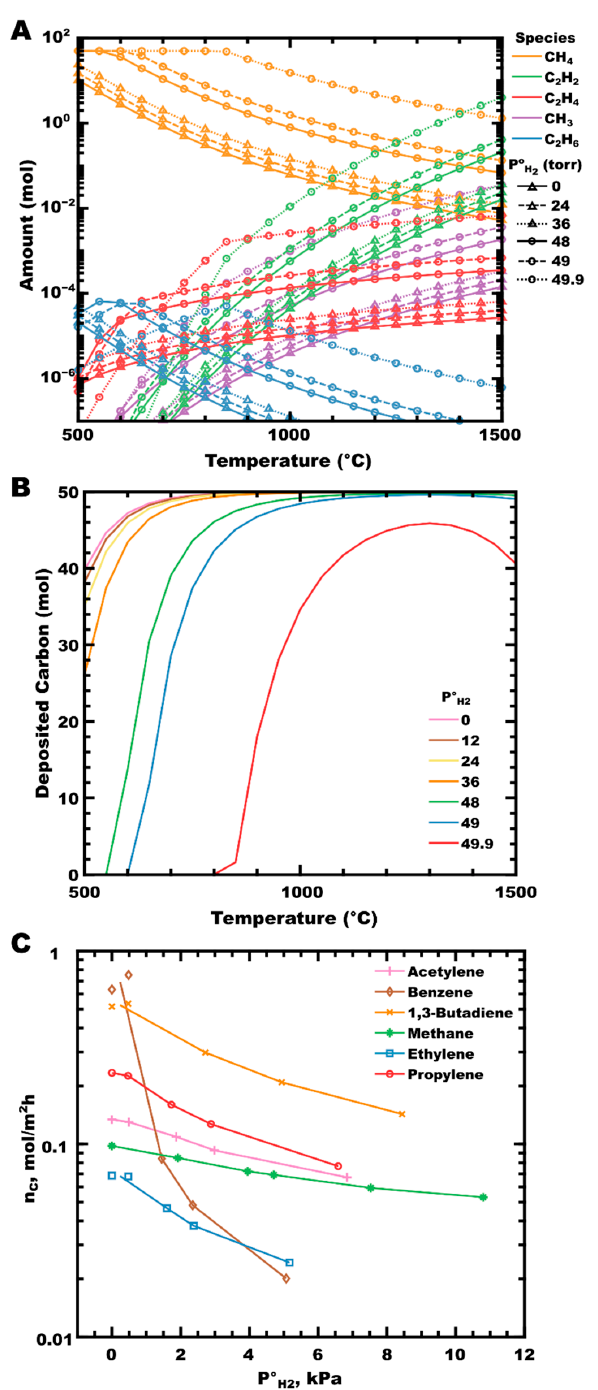
Figure 2. ( A ) The moles of hydrocarbons in CH 4 -H 2 mixtures are at equilibrium as P° H2 increases, at a total pressure of 50 torr. Line styles (shown in black) indicate P° H2 . ( B ) Moles of PyC deposited from 50 mol CH 4 in CH 4 -H 2 mixtures as P° H2 increases. Calculated in FactSage™ 8.1 (Thermfact Ltd. and GTT-Technologies). ( C ) Steady-state deposition rate of PyC from several hydrocarbons as the initial partial pressure of hydrogen increases; data taken from Refs [81,110,120] , with lines added to highlight trends.